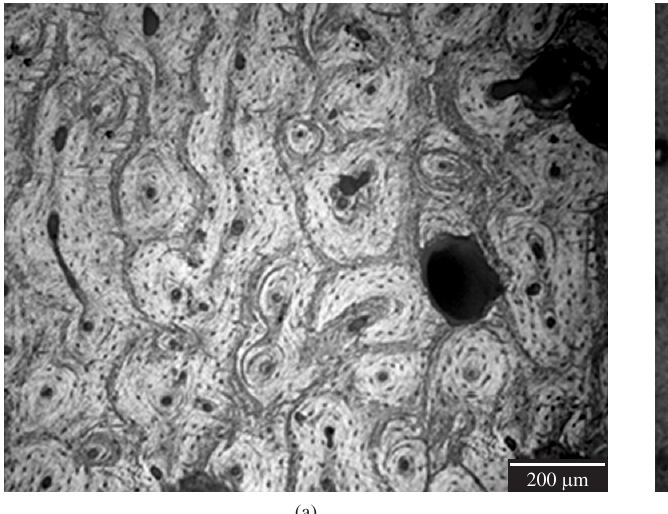
Figure 1. Optical micrographs: a) Bone and b) HAp.